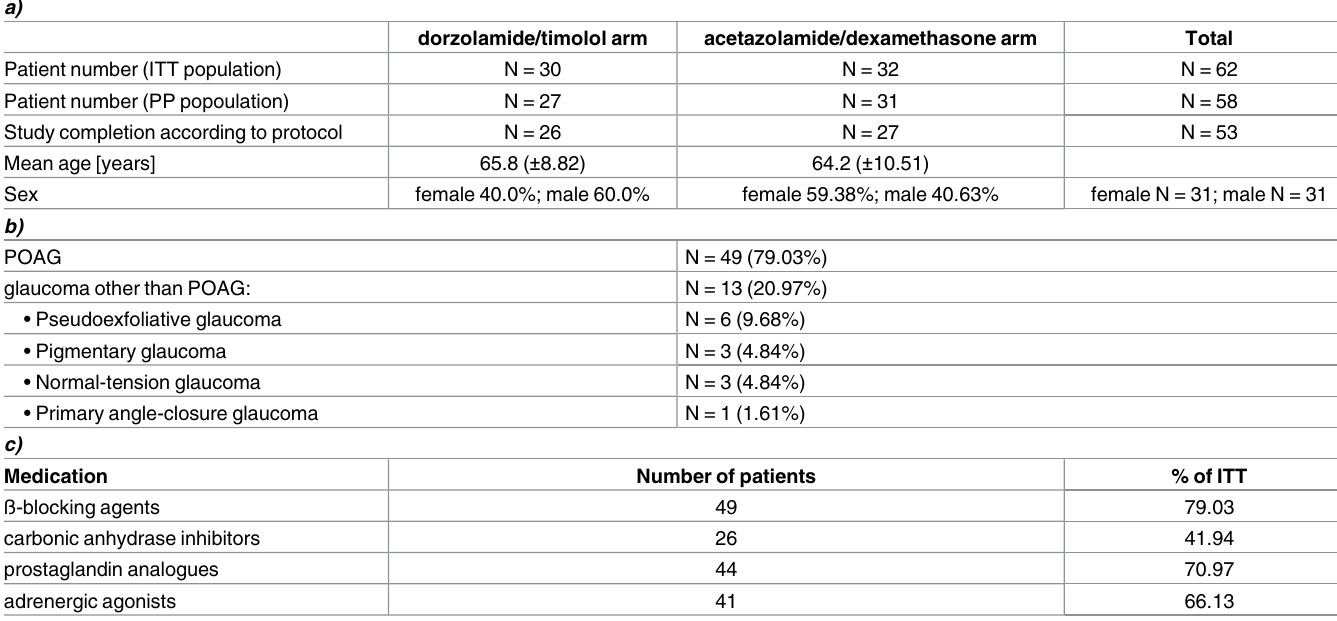
Table 3. Patient data. a) Generalpatient information, b) Distributionof glaucomadiagnosisin population, c) Previoususe of IOP-lowering eye treatments.